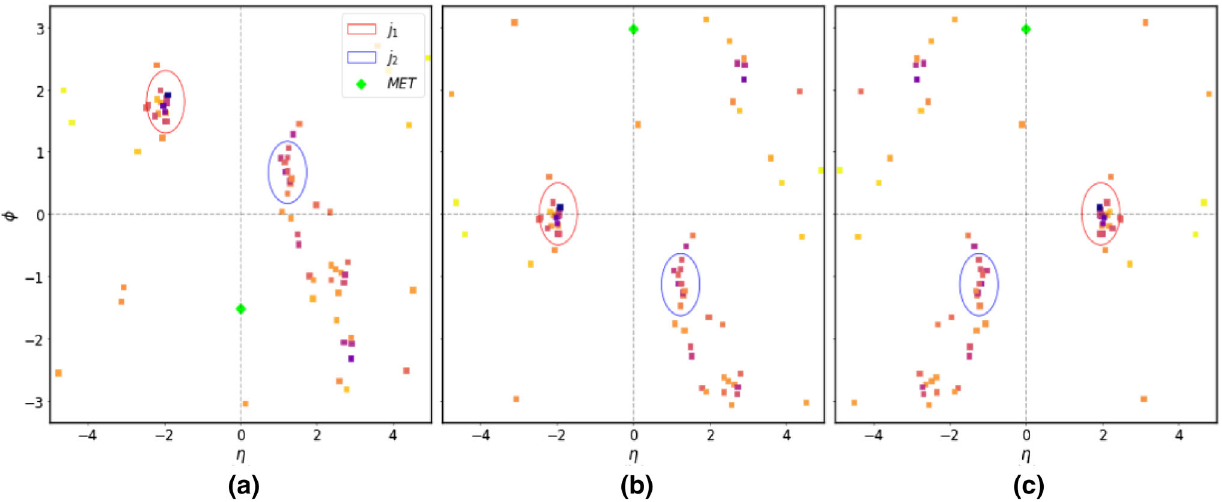
Fig. 8 Scatter plot of tower constituents of an event in the (η,φ) -plane showing: (a) the raw event; and the effects of (b) rotation ( φ j > 0) operations. The pseudorapidity of met has been (c) reflection ( η j 1